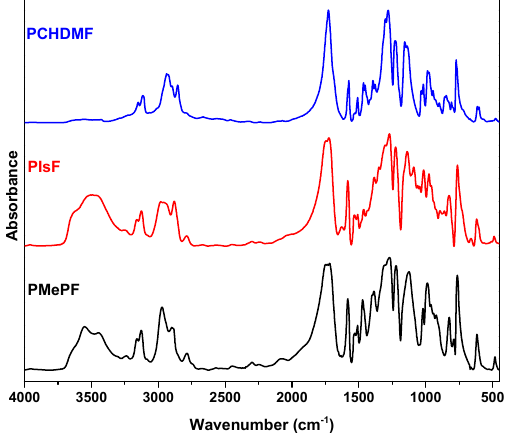
Figure 2. FTIR spectra of the polyesters.